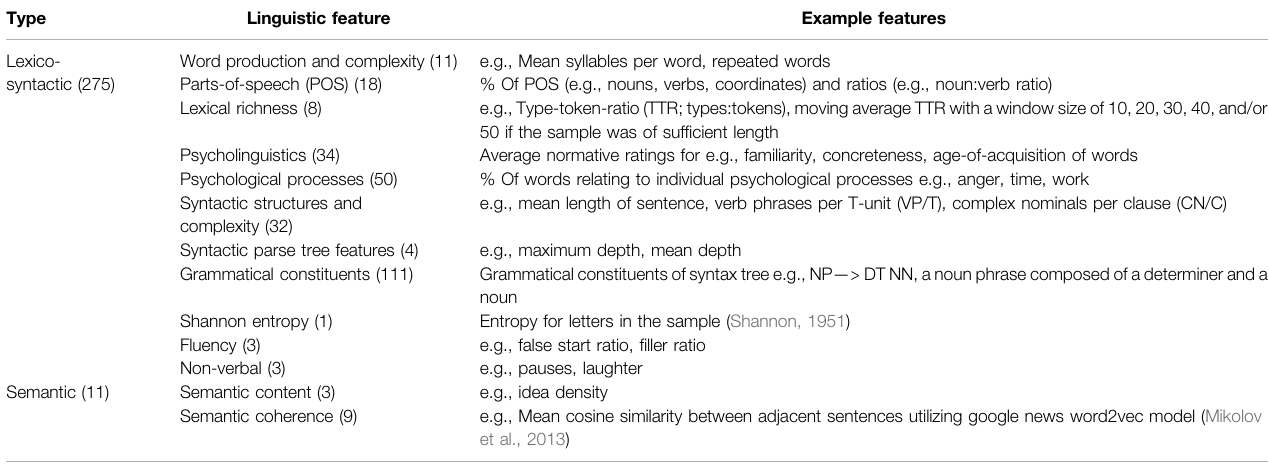
TABLE 2 | Linguistic domains covered by features extracted from each task transcript (number of features in brackets). Type Linguistic feature